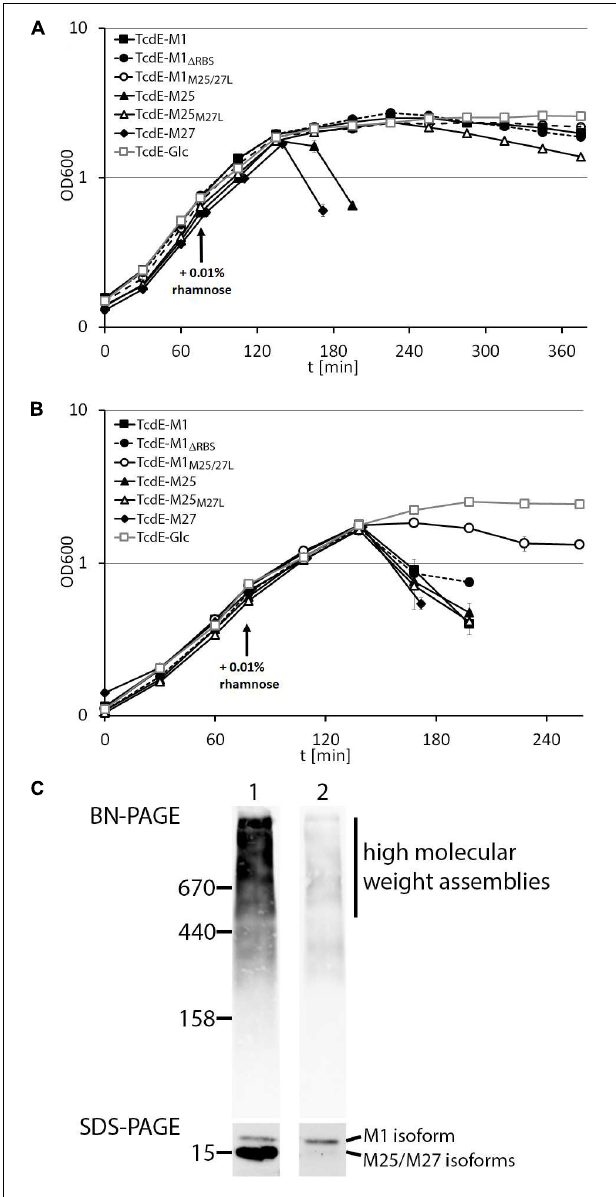
FIGURE 2 | TcdE-dependent lysis can be triggered by endolysins. Growth curves of E. coli strain ER2566 with recombinant rhamnose-induced production of either TcdE-M1, TcdE-M1 (cid:49) RBS , TcdE-M1 M25 / 27L , TcdE-M25, TcdE-M25 M27L , and TcdE-M27. As negative control, glucose instead of rhamnose was added to the strain containing the TcdE-M1 construct. Growth was without (A) or with (B) constitutive production of LysS from pLysS. Induction was with 0.01% rhamnose at the indicated time point. Standard deviations were calculated from three independent cultures. (C) BN-PAGE analysis of TcdE associations formed with the TcdE-M1 construct (1) and with the TcdE-M1 M25 / 27L construct (2), showing the presence of large TcdE associations using the E. coli strains ER2566 pBW- tcdE-M1 -H6 and pBW- tcdE -M1 M25 / 27L -H6, respectively. SDS–PAGE analysis of the TcdE isoforms, showing that the strain with the TcdE-M1 construct contains also highly abundant smaller isoforms, whereas the TcdE-M1 M25 / 27L construct contains very low amounts of smaller isoforms. Western blot detection using His-tag antibodies and ECL reaction. Molecular weight markers (in kDa) are indicated on the